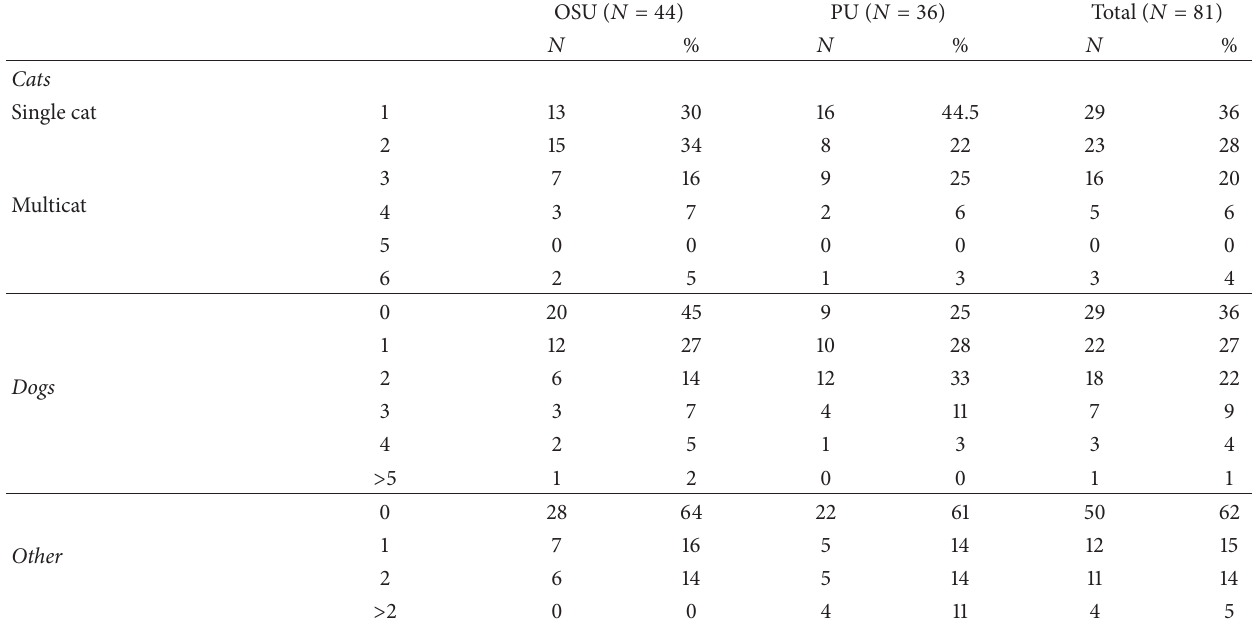
Table 2: Other animals in the home-the number of cats, dogs, and other pets in the